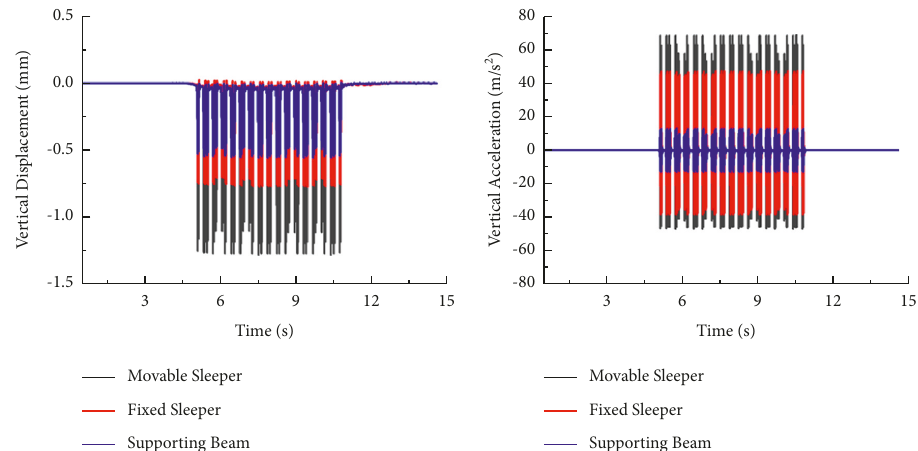
Figure 11: Time histories of the vertical dynamic response of BEJs in Case 1.